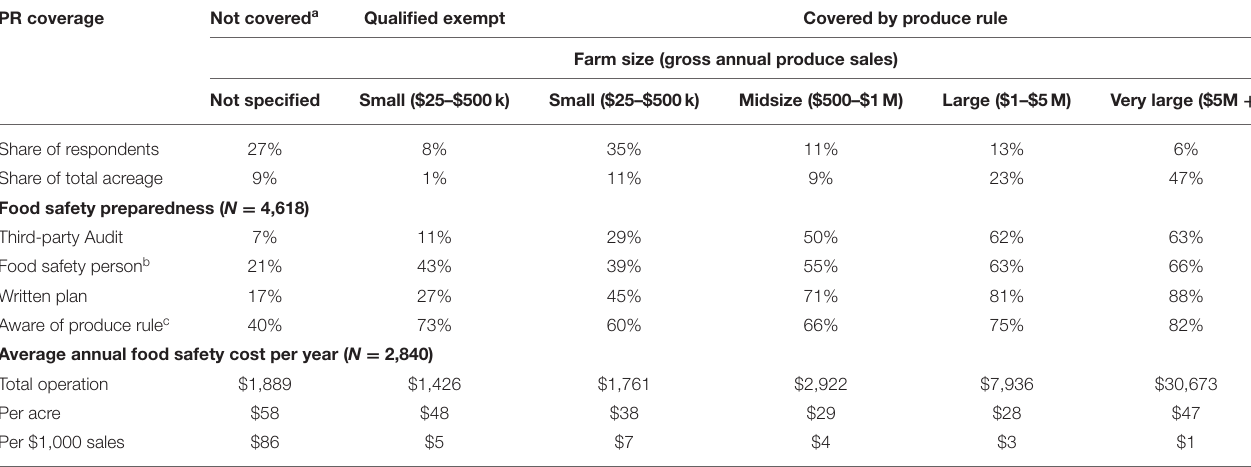
TABLE 5 | Selected results of 2015–2016 national survey of fruit and vegetable growers. PR